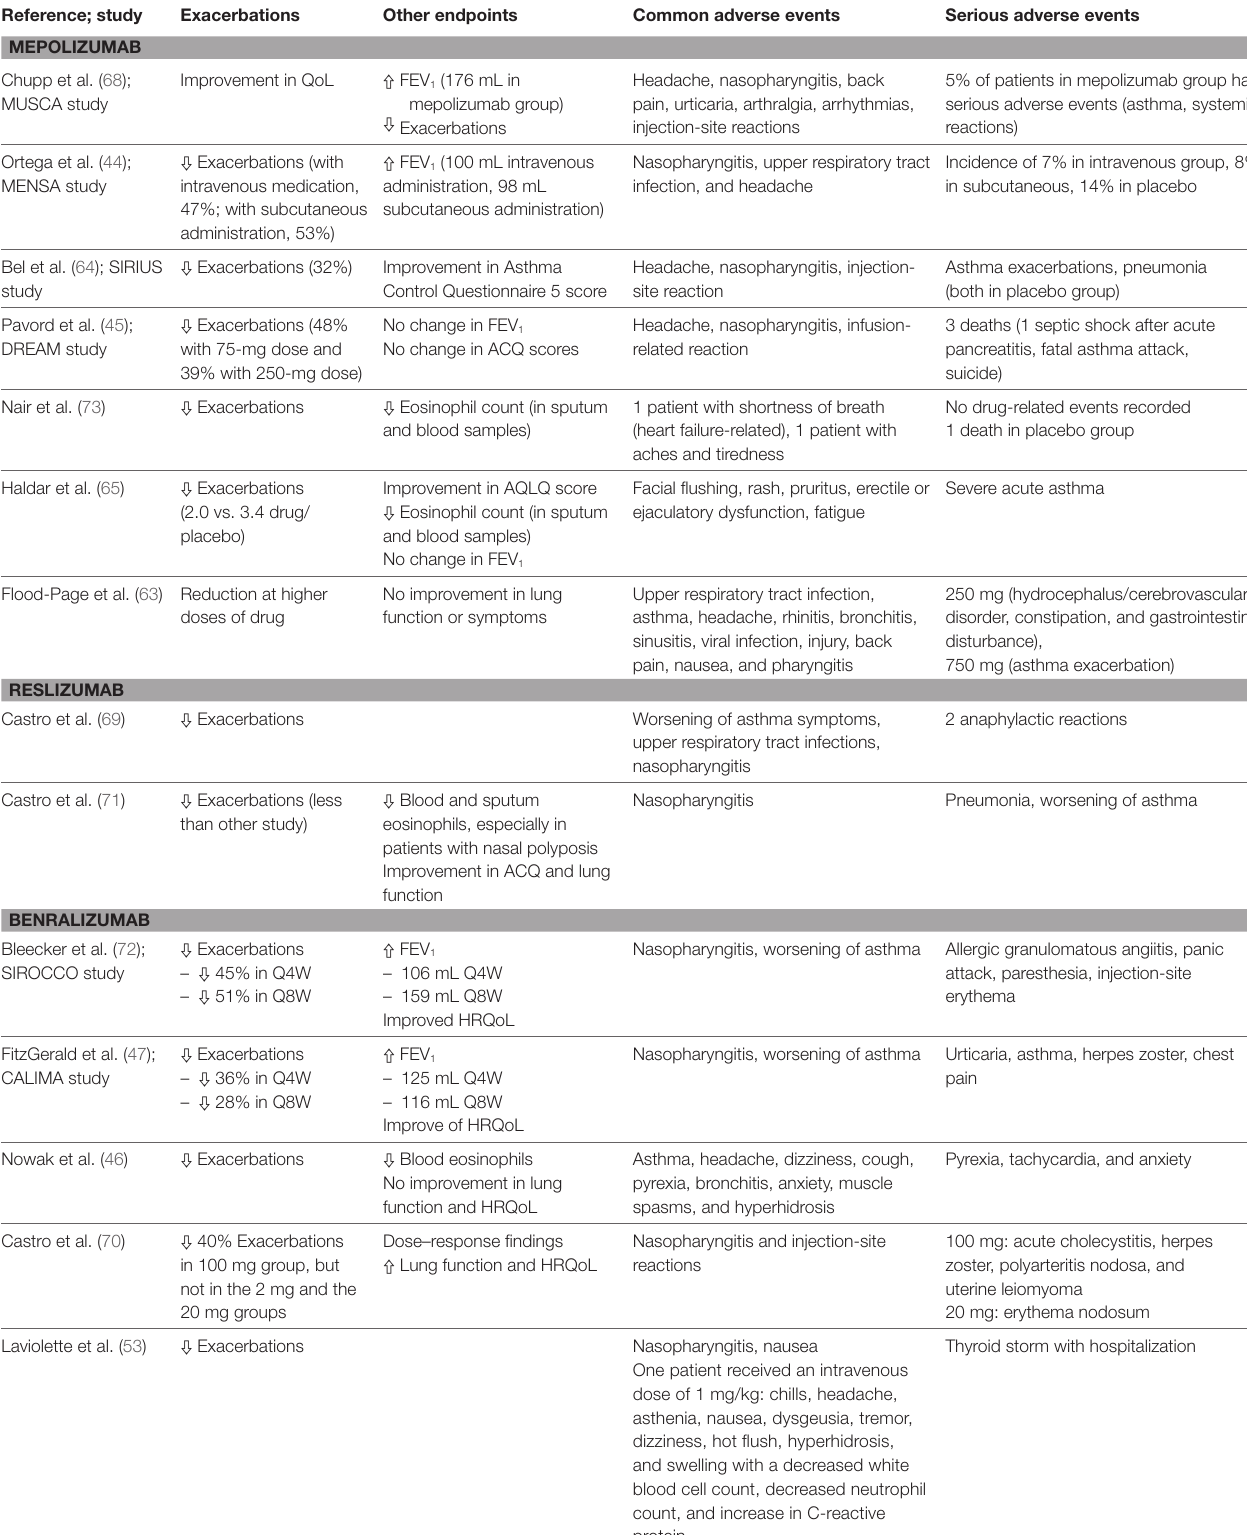
TABLe 1 | Clinical trials on anti-interleukin 5 (IL-5) and IL-5Ra antagonists: main results and safety findings. Reference;